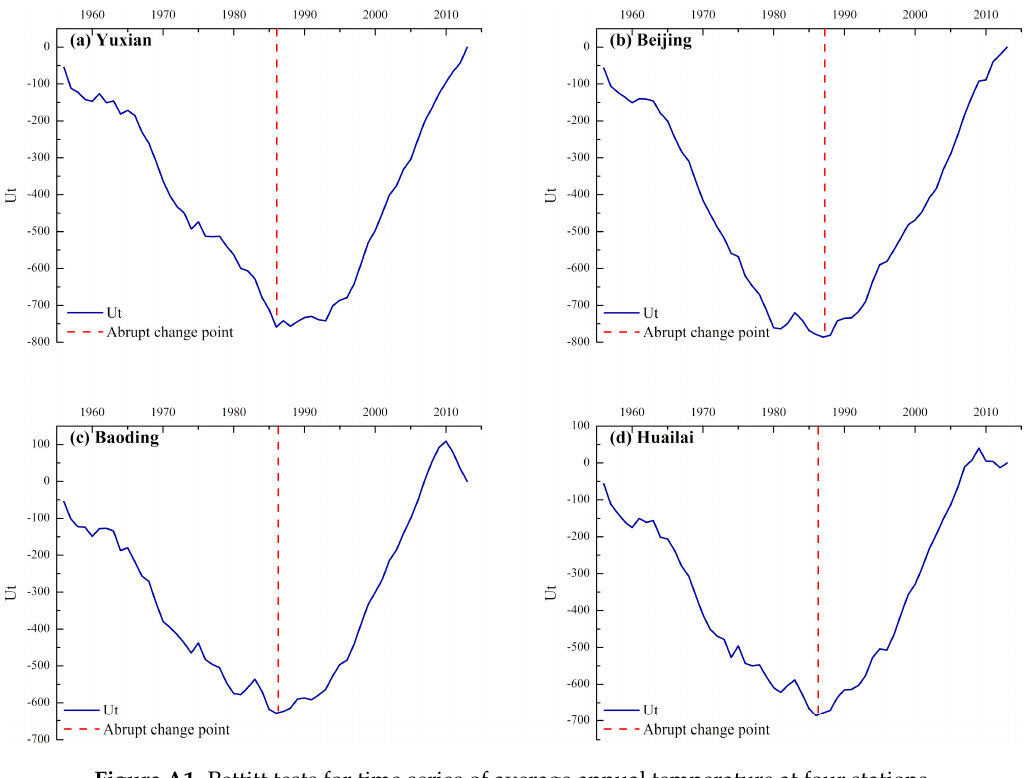
Figure A1. Pettitt tests for time series of average annual temperature at four stations.